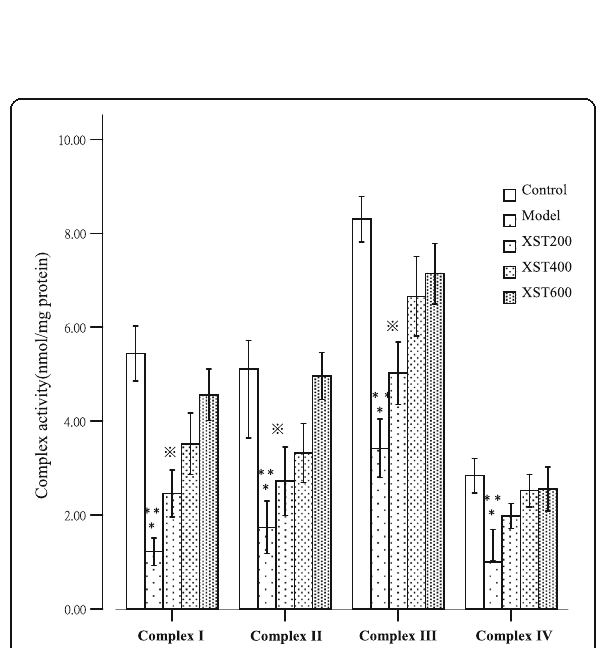
Fig. 5 The activities of complexes I-IV were decreased variable in the model group, XST could dose dependently restore the activities of complexes I, II and III, but complex IV showed no difference among the three XST-treated groups. All samples were checked in three independent experiments with three replicates each. Data are represented as the mean ± SD ( * P < 0.05 vs. XST 200 μ g/ml or XST400 μ g/ml, ** P < 0.001 vs. the control or XST 600 μ g/ml, ※ P < 0.05 vs. XST 400 μ g/ml or XST600 μ